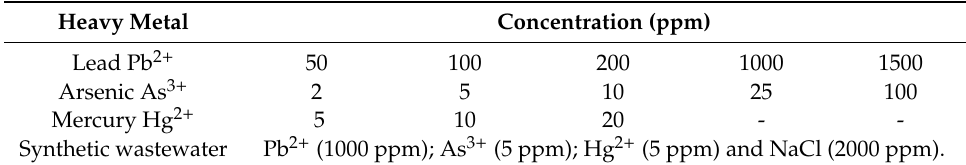
Figure 1. The air gap width was about 5 mm. Three types of flat sheet polytetrafluoroethylenes (PTFE) microporous hydrophobic membranes were employed in this study, as shown in Table 2. Table 1. Range of concentration of heavy metals used in the filtration process. Heavy Metal Concentration